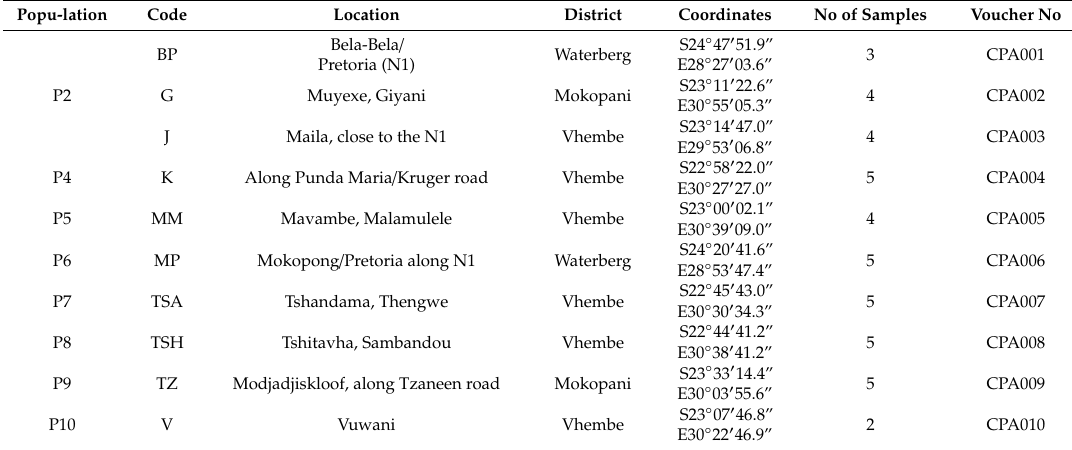
Table 3. Coordinates of the locations where samples were collected and the corresponding voucher specimen